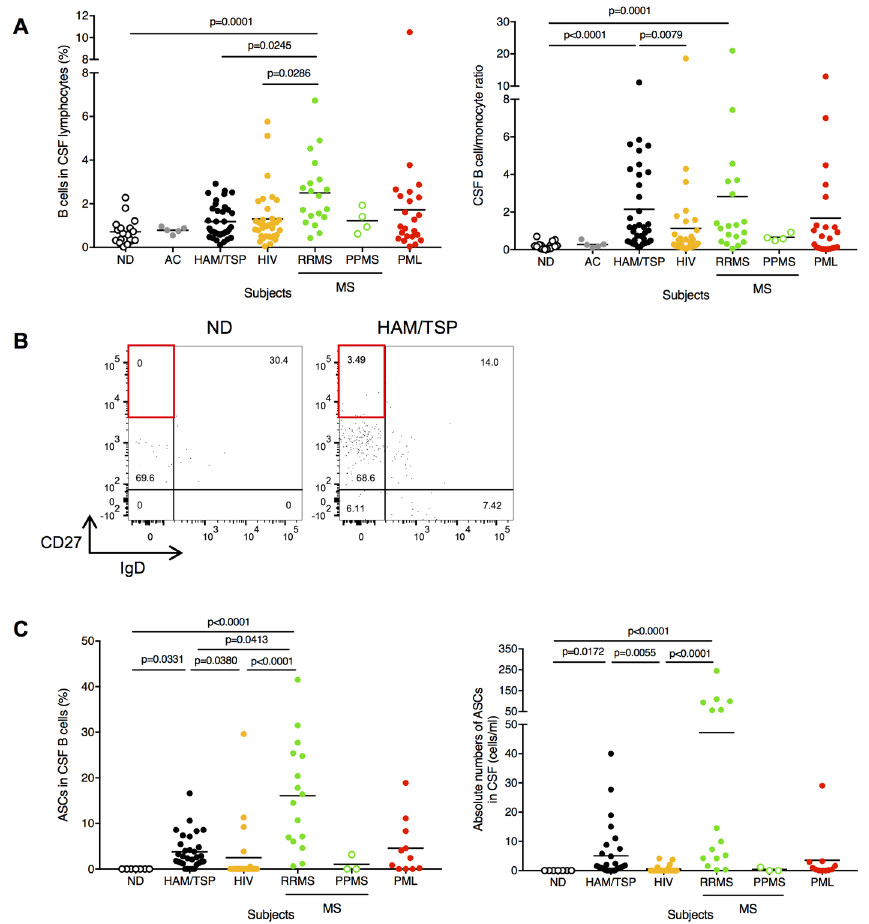
Fig 1. Detection of B cells in CSF of chronic virus infection and/or neuroinflammatory diseases. (A) Comparison of frequencies of B cells (left) and B cell/monocyte ratio (right) in CSF using Kruskal-Wallis test with Dunn’s test. The horizontal line represents the mean. (B) Detection of ASCs subset in B cells of CSF. (Left) Representative dot plots of IgD and CD27 staining in CSF CD19 + B cells of a ND and a HAM/TSP patient. IgD - CD27 ++ subsets (red rectangles) represent ASCs. (C) Comparison of frequencies of ASCs (left) and absolute number of ASCs (right) in CSF using Kruskal-Wallis test with Dunn’s test. The horizontal line represents the mean.